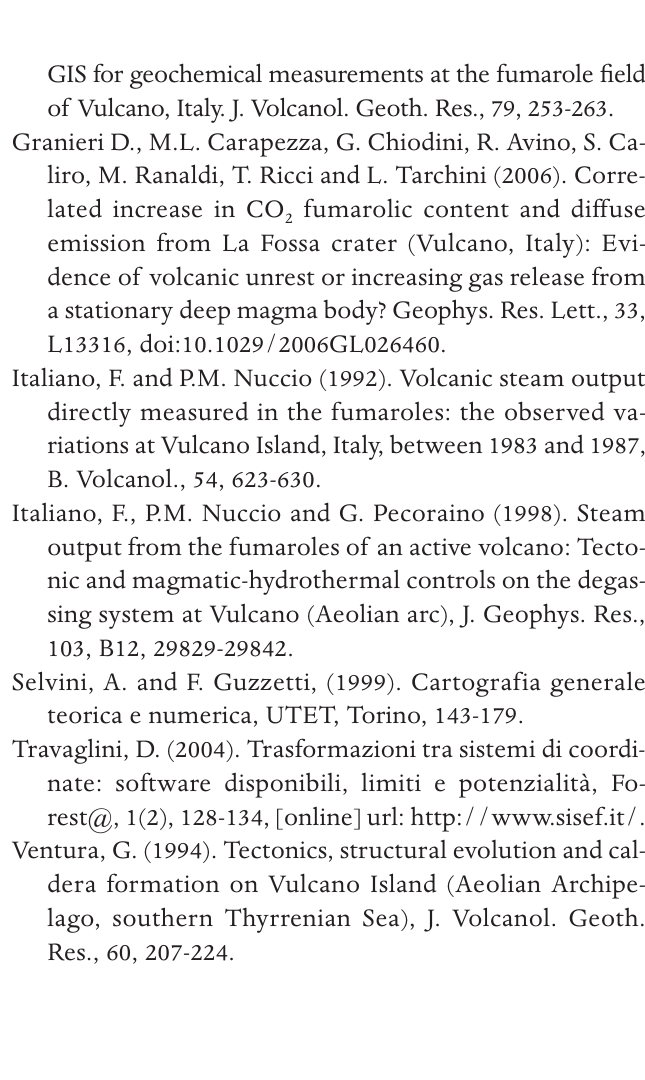
Figure 9. Fumarole positions. Red, converted uncorrected areas; blue, corrected areas; yellow, results from the new GPS survey carried out in October 2009; gray crosses, points used for georeferencing; black lines, elevation contour lines in m